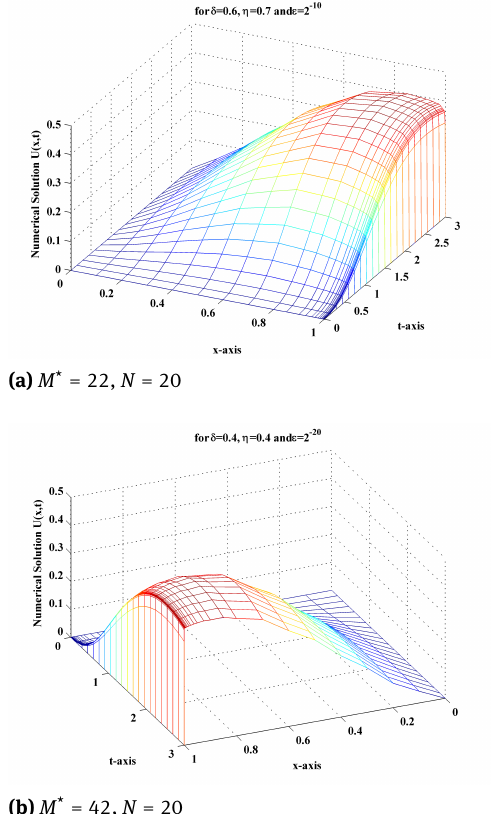
Fig. 2: Numerical solution of example 5.1, using uniform mesh and adaptive mesh for three different time level with ε = 2 −14 , δ = 0.2 , η = 0.4 , M=30 and N=20.